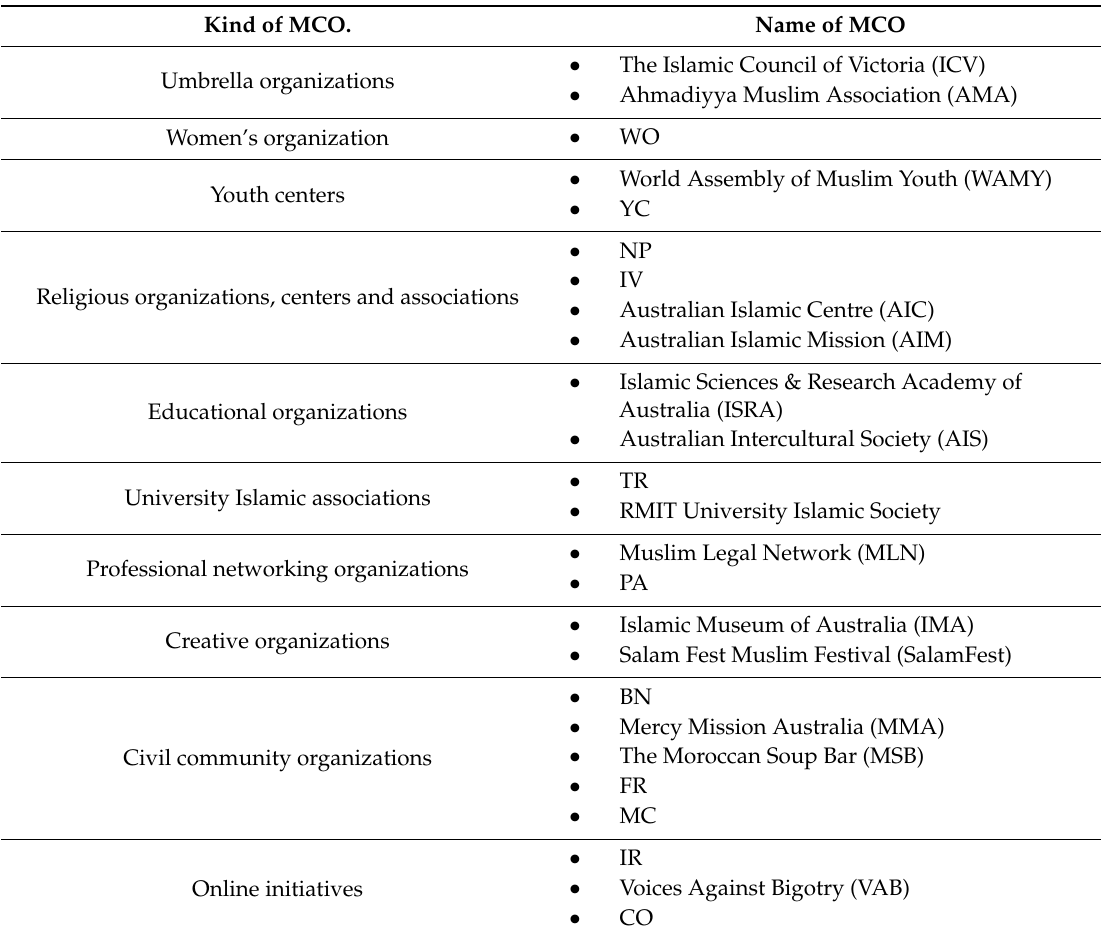
Table 1. List of participating Muslim Community Organizations (MCOs). Kind of